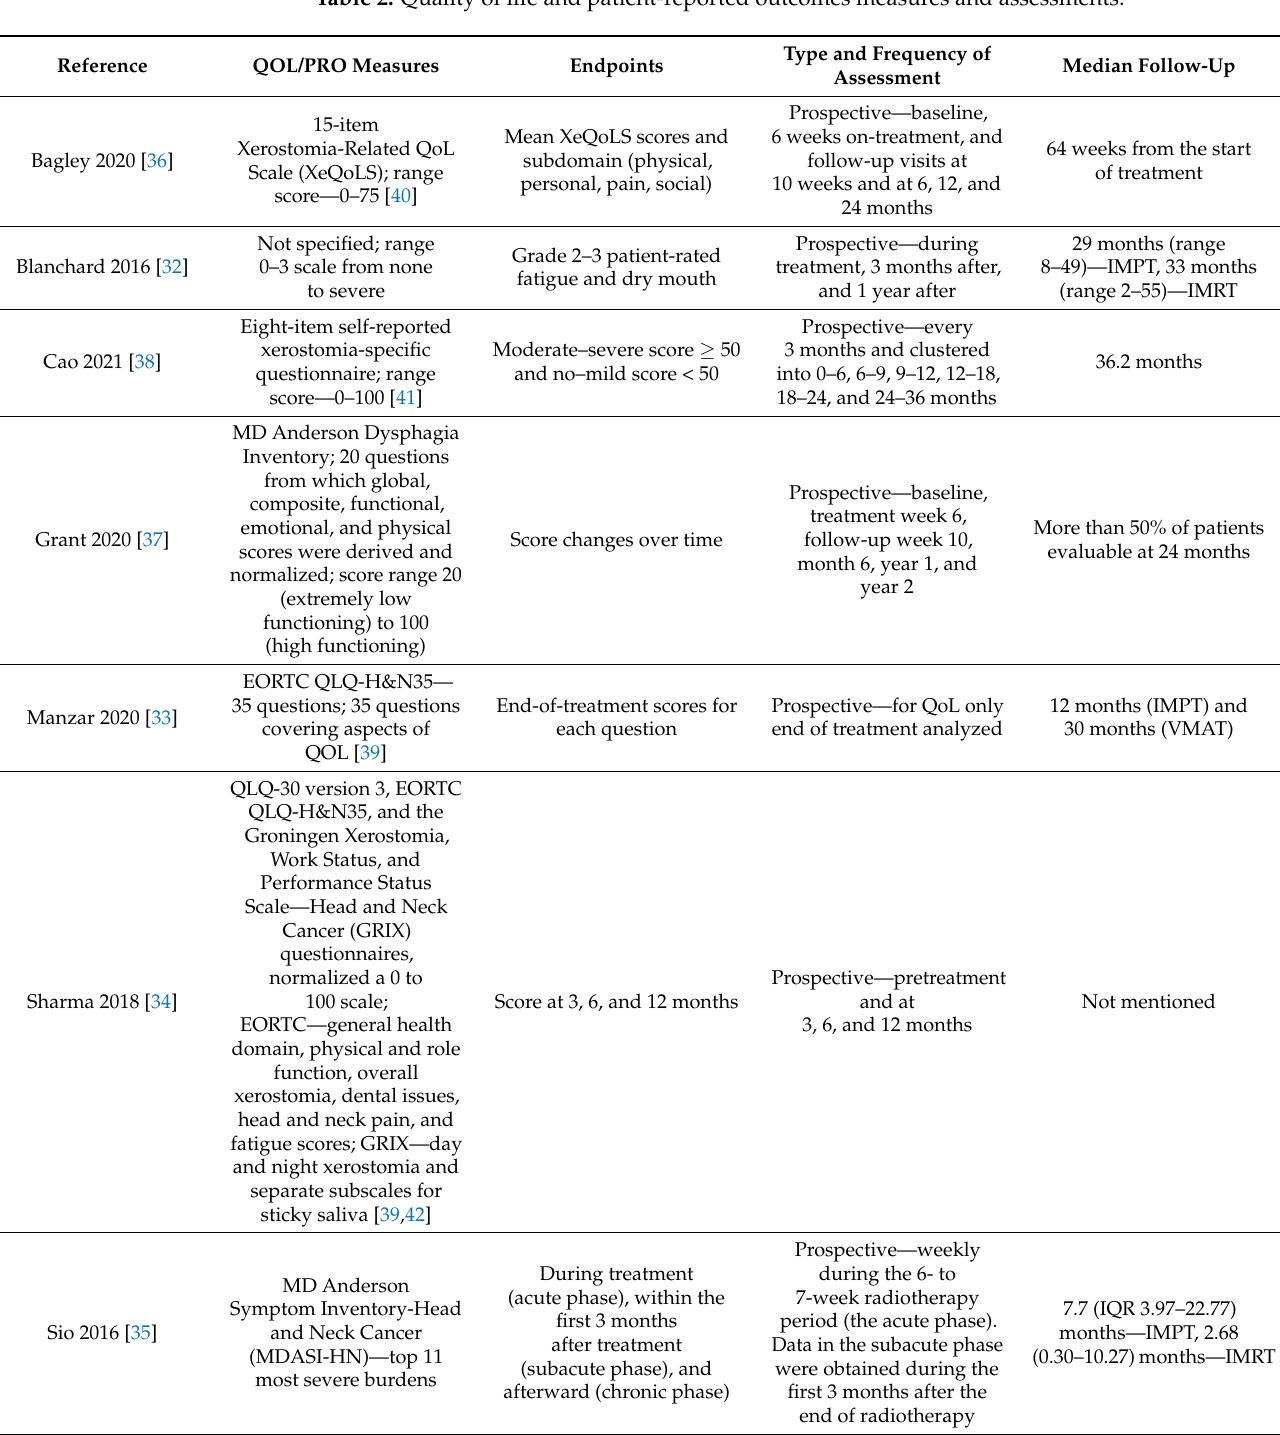
Table 2. Quality of life and patient-reported outcomes measures and